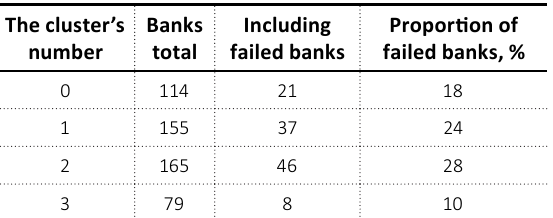
Table 4. SOM (2014–2017). Analysis of bank